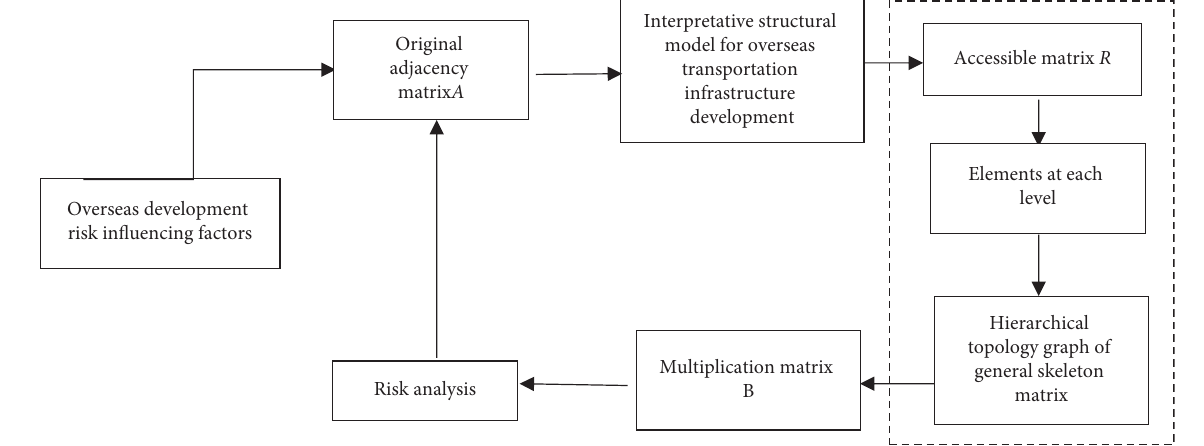
Figure 1: Steps of structural model